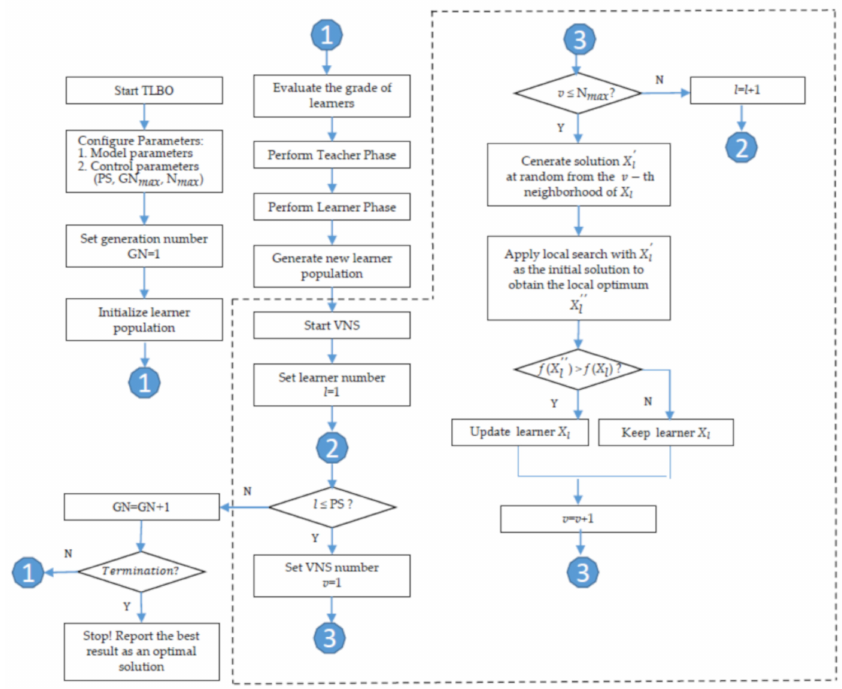
Figure 1. The solution process of the proposed teaching–learning-based optimization (TLBO)-variable neighborhood search (VNS)